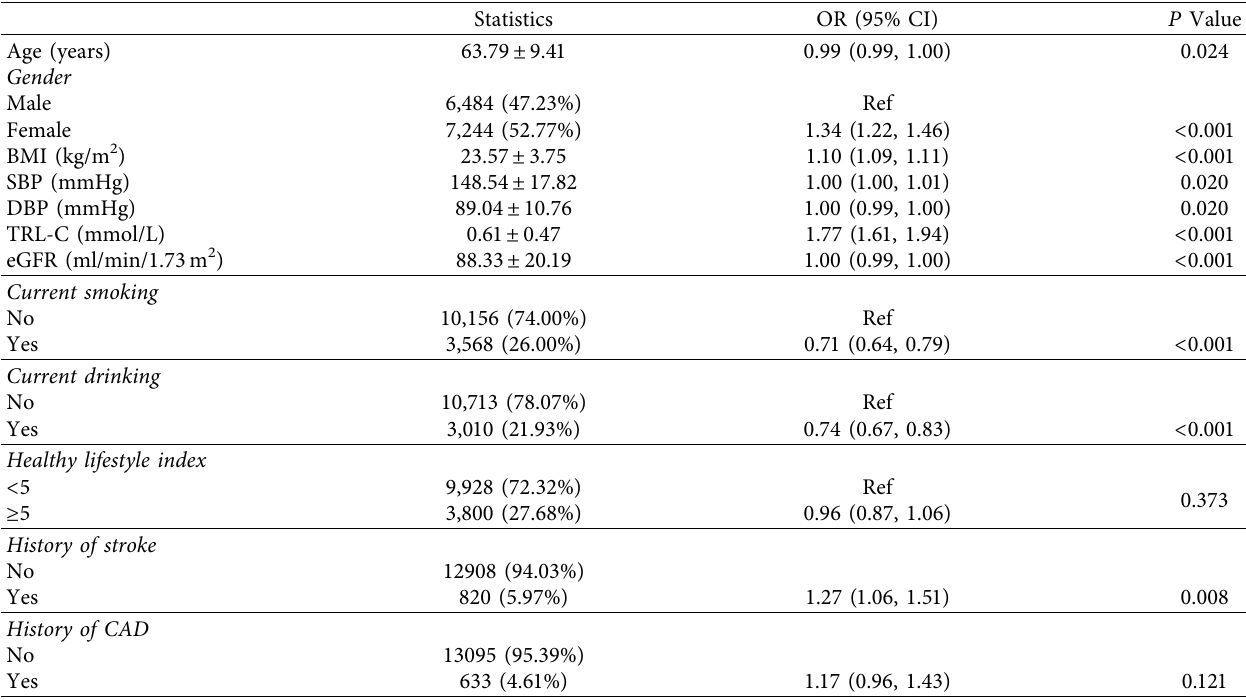
Table 2: Crude association of DM with common risk factors analyzed by univariate analysis.